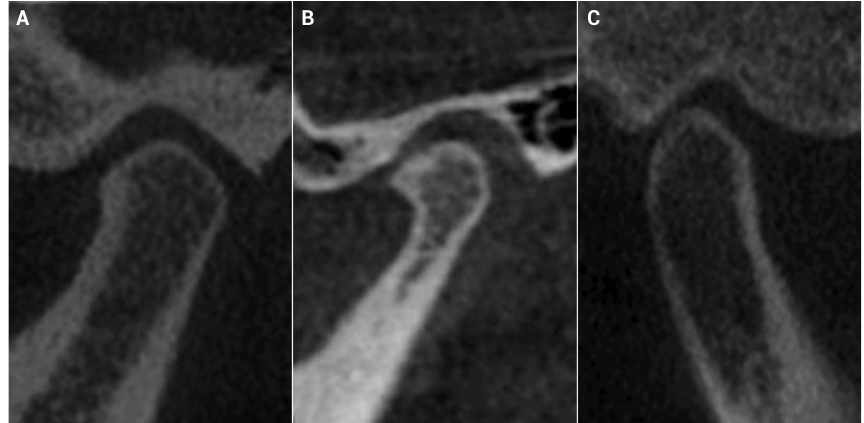
Figure 3. Example positions of the condyle in the mandibular fossa. (A) equidistant; (B) anteriorized; (C)